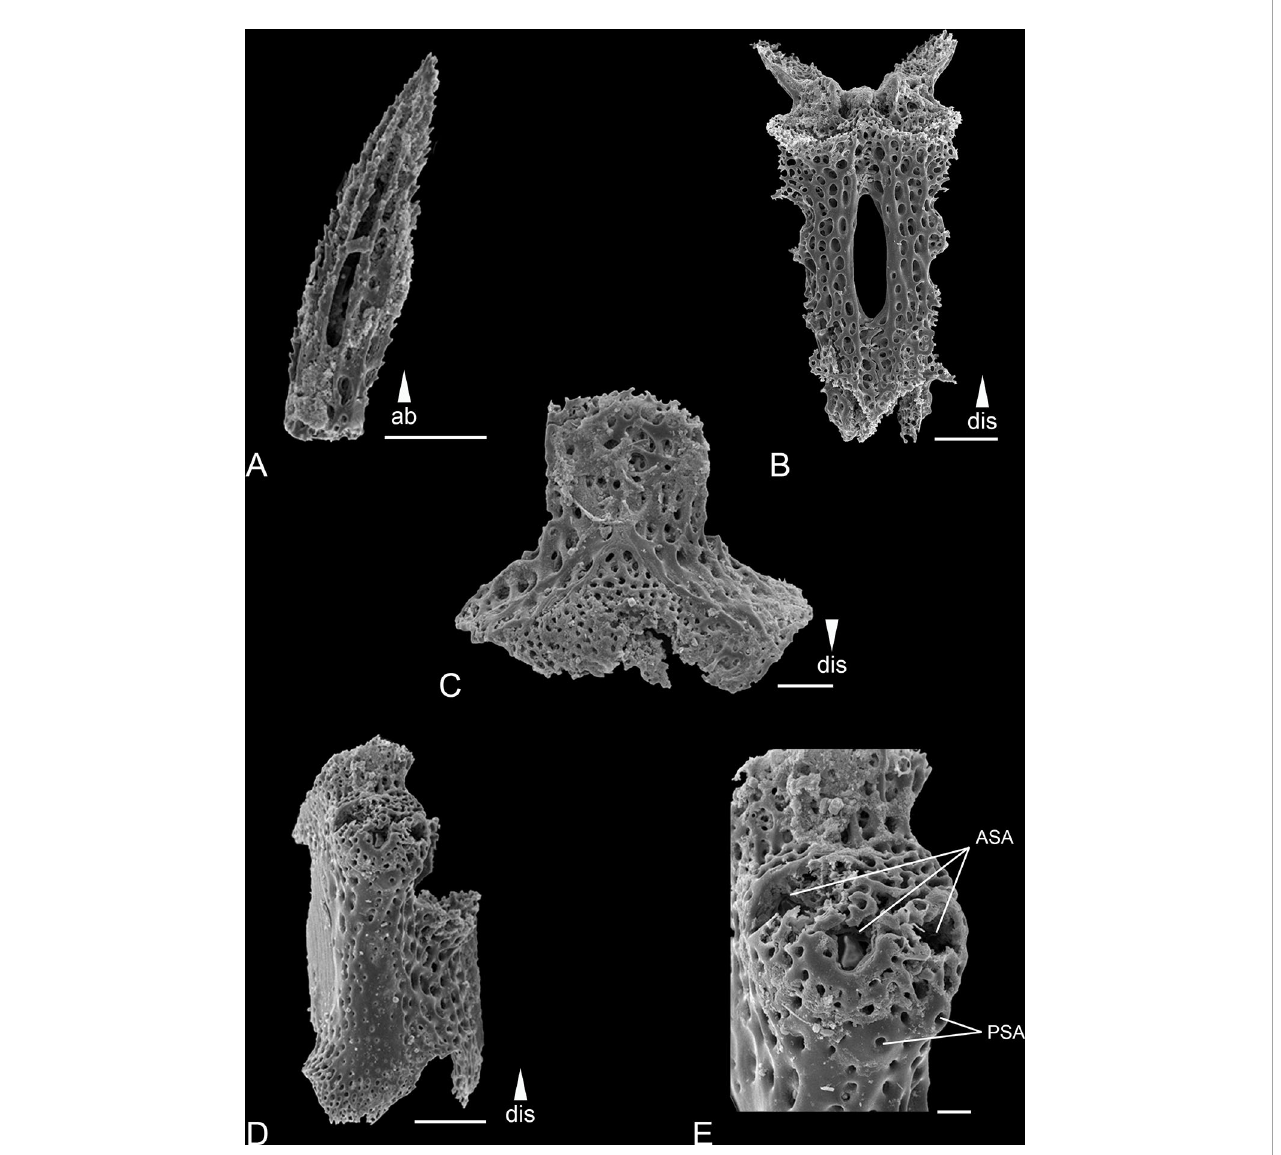
FIGURE 3 Scanning electron microscope images of the ossicles from Ophiotholia gibbosa . (A) : Arm spine; (B) : Ventral arm plate; (C) : Arm vertebrae (ventral); (D) : Lateral arm plate; (E) : Lateral arm plate close up. Scales: 20 µm (E) ; 50 µm (B) ; 100 µm (A, C, D) ;. ab, abradial; ASA, arm spine articulation; dis, distal; PSA, parasol spine